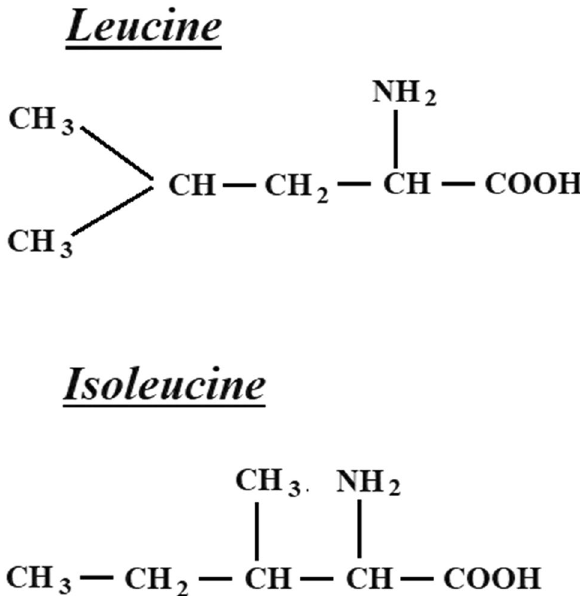
Figure 1. Structural formula of leucine and isoleucine.